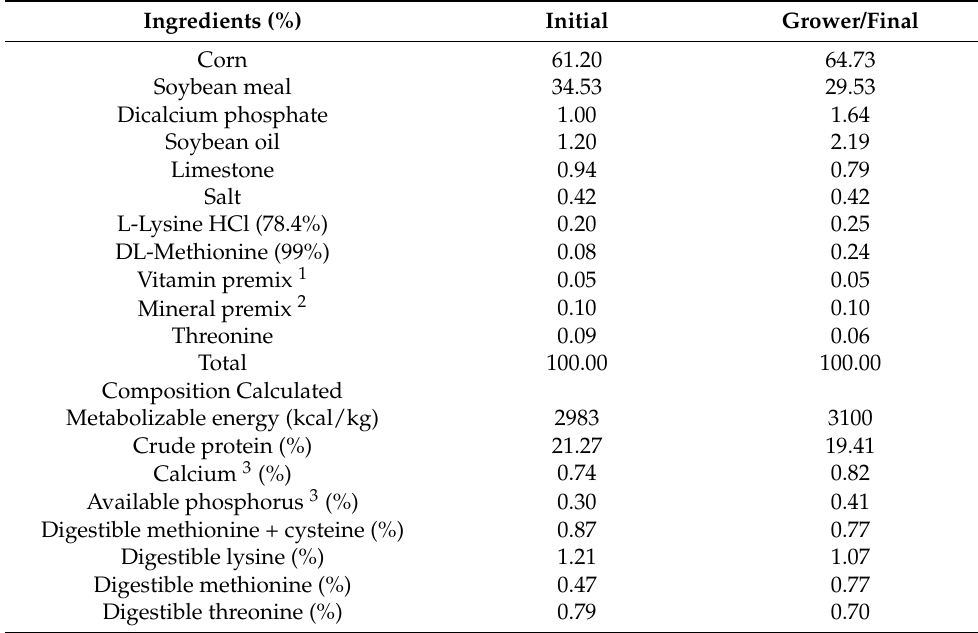
Table 4. Progeny trial: composition of the basal progeny